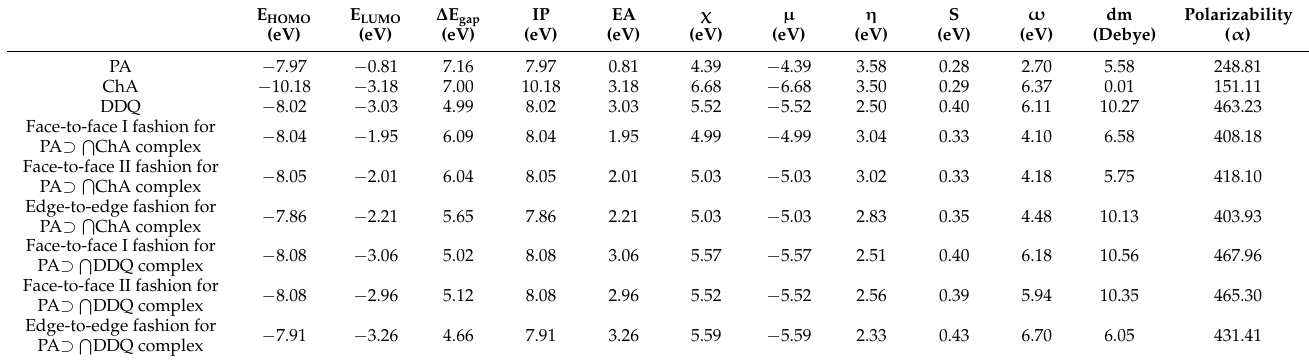
Table 5. HOMO-LUMO gap ( ∆ E gap ), ionization potential (IP), electron affinity (EA), electronegativity ( χ ), chemical potential ( µ ), hardness ( η ), softness (S), electrophilicity index ( ω ), dipole moments (dm), and polarizability ( α ) of the PA, ChA, DDQ, and their complexes at the ω B97XD/6 − 311++G(d,2p) level of theory in acetonitrile